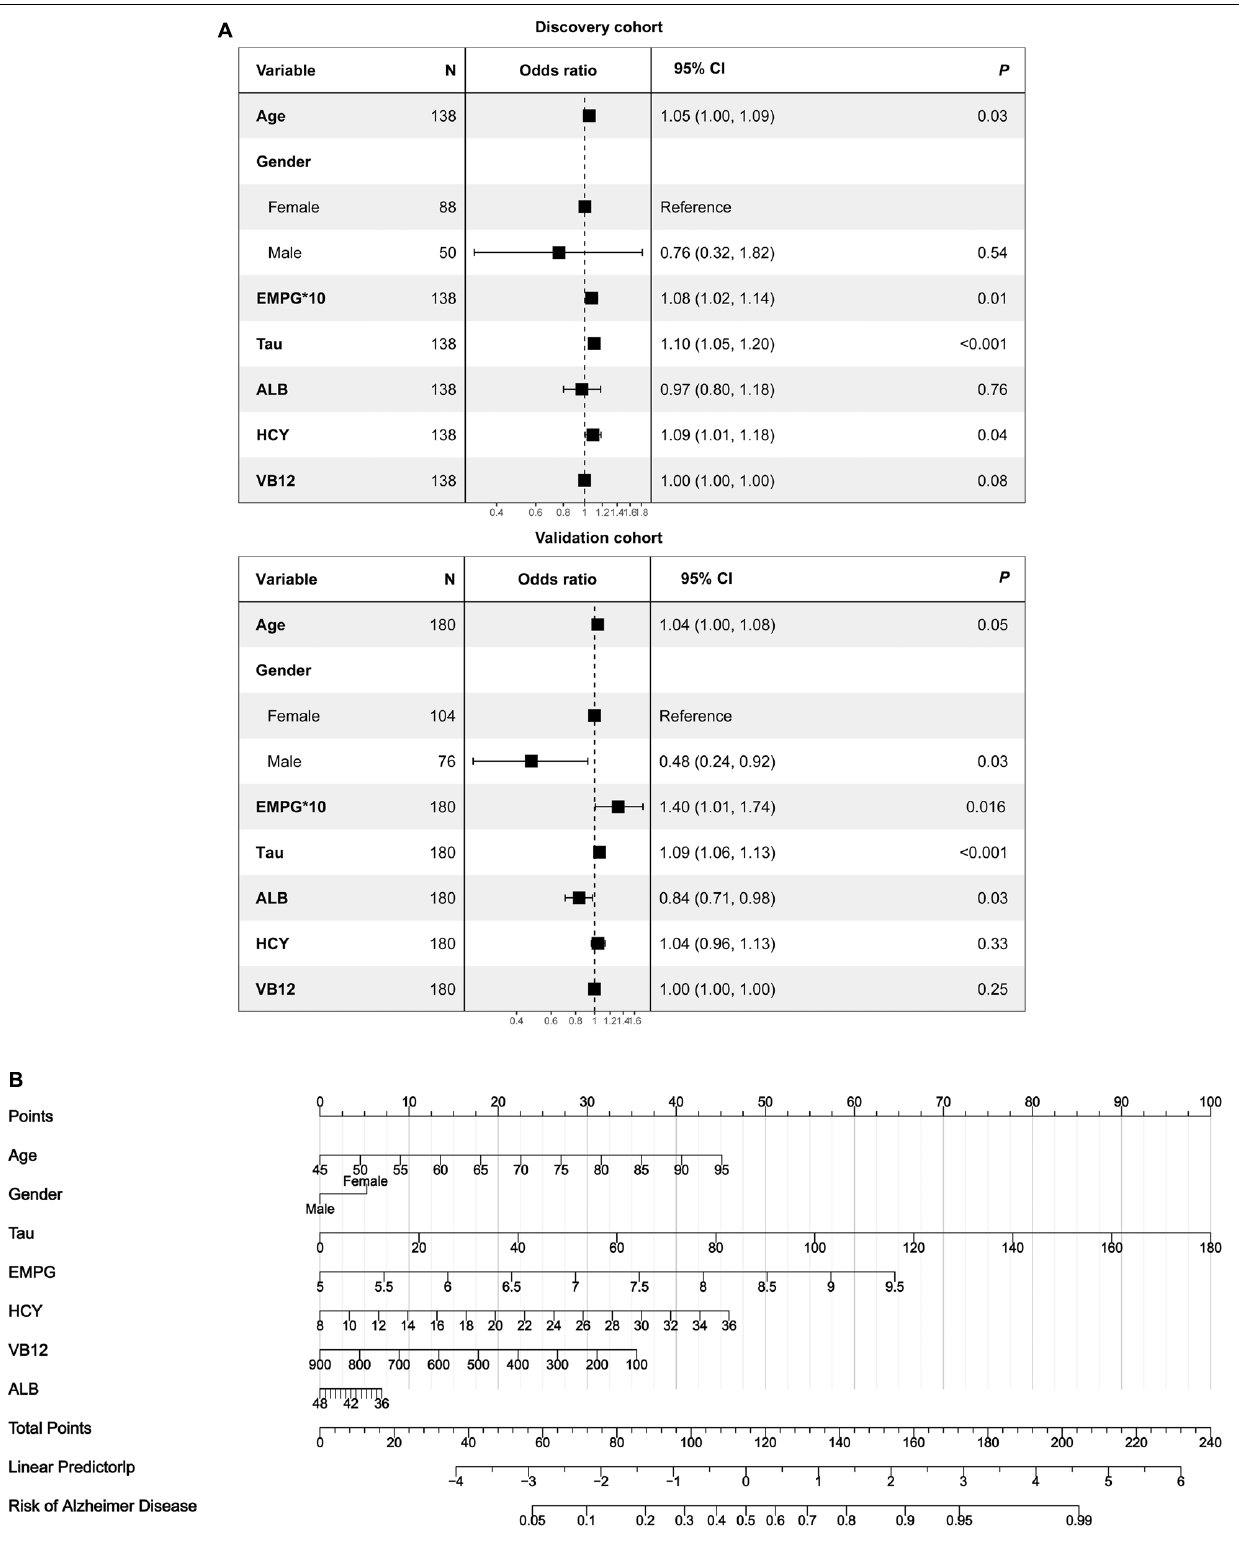
Frontiers in Aging Neuroscience |